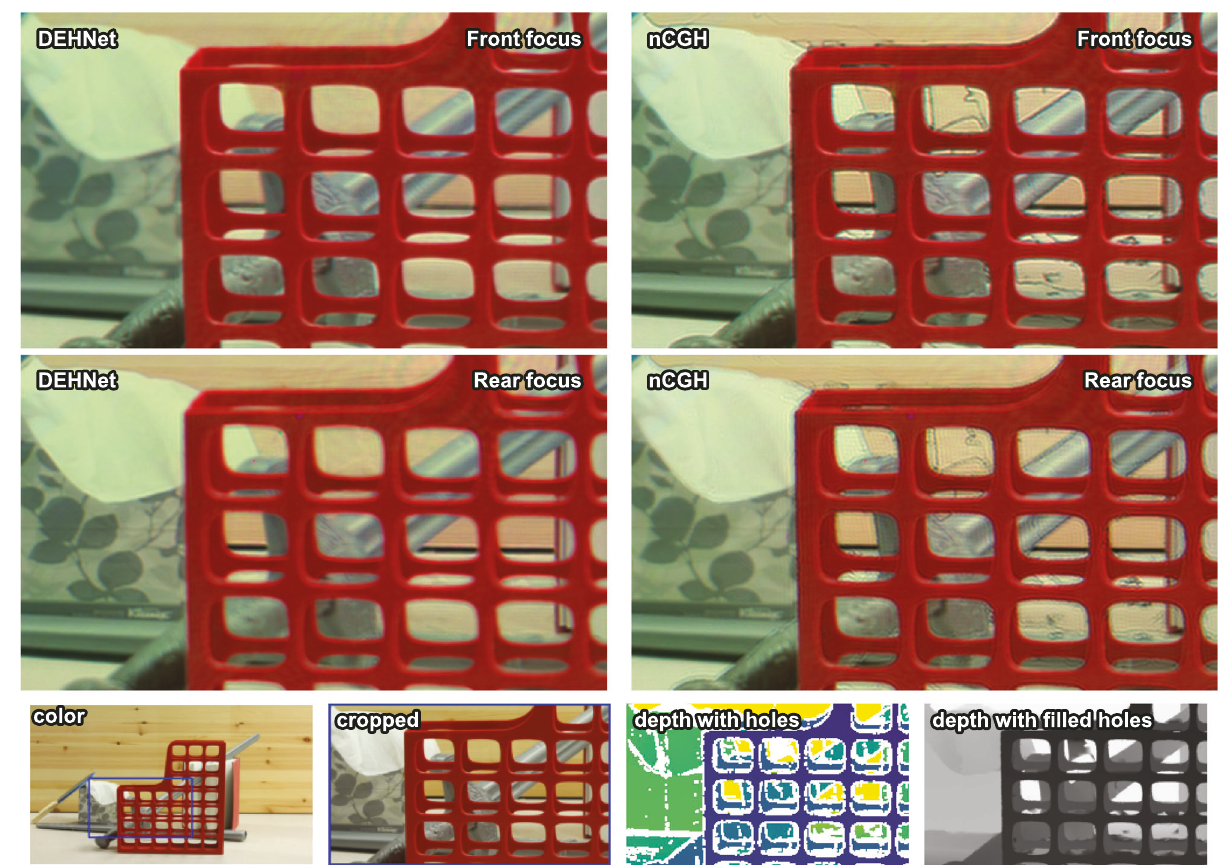
Fig. 7 | Experimental results obtained using a real-world RGB-D image. Using a real-world-captured RGB-D image 39 , a DEH and an nCGH were synthesized and optically reconstructed. Since the real-world depth map includes depth holes, a monoculardepthestimationalgorithm 57 wasadoptedto fi lltheholes.Theoptically reconstructed images are cropped to show the details. Black lines caused by wave